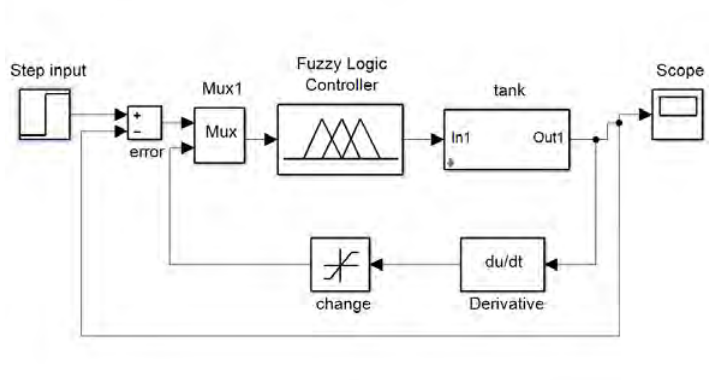
Figure 7. a) Simulink block diagram for non linear conical process tank